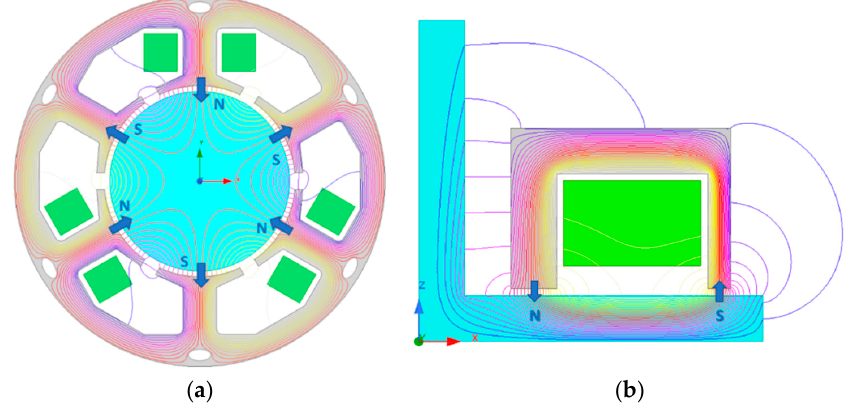
Figure 1. Configurations of an active magnetic bearing with the flux lines generated by the excited coils: ( a ) radial heteropolar type; ( b ) axial homopolar type acting on a disc integral with the shaft.